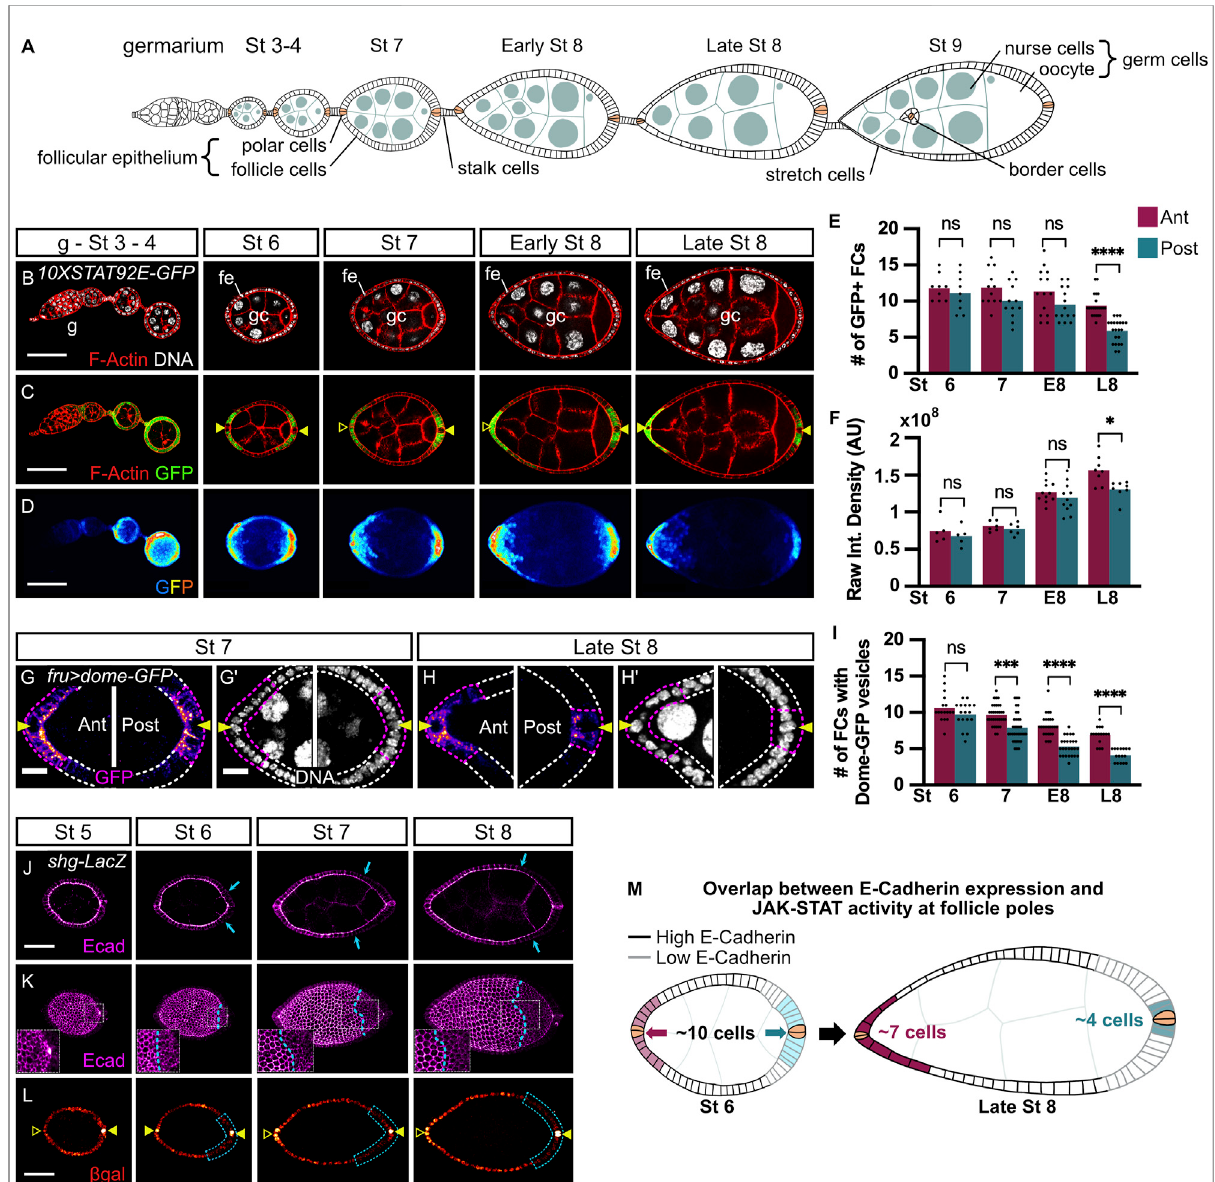
FIGURE 1 JAK-STAT signaling activity and E-cadherin expression are dynamic and asymmetric between anterior and posterior poles starting at stages 7and6ofoogenesisrespectively.Inallimagesanddrawings,theanterioristotheleft.FilledarrowheadsindicatePCs.Emptyarrowheadsindicatethe positionofPCsalongthe z -axiswhennotvisibleonthedisplayedzsection.Ingraphs,purpleandbluebarsrepresentmeanmeasurementsatanterior (ant)andposterior(post)polesrespectivelyandeachdotcorrespondstoonemeasurement. (A) Schematicdrawingillustratingtheorganization of an ovariole with the germarium (G) located at the anterior-most tip and older stages towards the posterior end linked by the stalk cells. The somatic follicle monolayered epithelium (fe), composed of follicle cells (FC), including polar cells (PC, in beige), border cells, and stretch cells surrounds the cyst of 16 germ cells (gc) comprising 15 nurse cells and 1 oocyte that is anchored at the posterior pole. (B – D) Follicles from 10XSTAT92E-GFP hemizygous females carrying a STAT92E transcriptional reporter at the indicated stages of oogenesis (B) F-Actin (red, phalloidin) and DNA (grey, DAPI) staining. (C,D) Native GFP (C: green, one confocal section; (D) “ royal ” fi lter, sum projection of total GFP signal) re fl ects JAK- STAT activity at each pole forming a gradient in FCs adjacent to PCs. (E) The mean number of GFP + FCs at each pole counted on one confocal section that includes PCs. From stage 7, GFP + FC number decreases at the posterior pole and is signi fi cantly lower than at the anterior pole when follicles attain late stage 8 (L8). (F) Raw Integrated Density quanti fi cation of 25% of follicle length starting at each pole on the sum projection of total GFP signal. At L8, GFP intensity is signi fi cantly lower at the posterior pole than at the anterior pole (G,H) Stage 7 and L8 follicles from females expressing UAS-dome-GFP in FCs with the fru-Gal4 driver (max projection of 3 – 6 confocal sections of anterior and posterior follicle poles). The number of FCsactive for JAK-STAT signaling (purpledotted lines) adjacentto PCs (arrowheads) wasdetermined bycountingFCs containingDome- positivevesicles( “ fi re ” fi lter,frompurple,lowintensity,toorange,highintensity). (I) MeannumberofFCscontainingDome-GFPvesiclesateachpole shows a progressive decrease at both anterior and posterior poles from stage 7 to L8, but more drastically at the posterior pole with signi fi cant